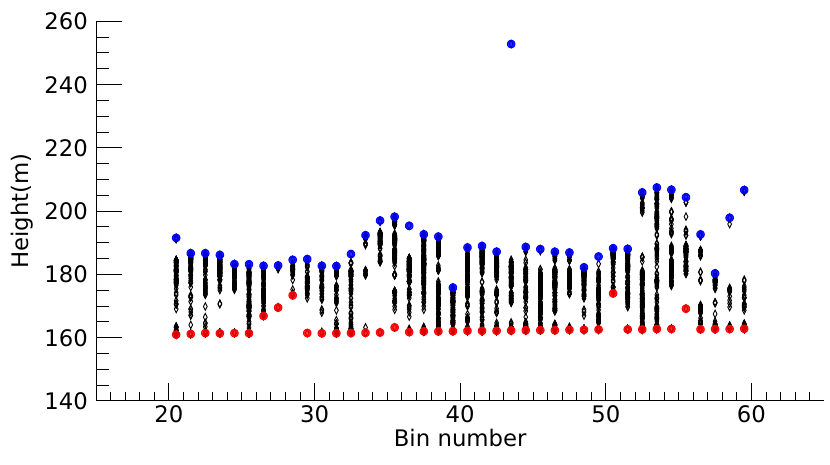
Figure 6. A small section of contiguous bins. Height values are shown in black centered on the correspondent bin. The top value, displayed in blue, is used when constructing the surface image. The bottom value, displayed in red, is used when constructing the terrain image. An outlier influence is visible on bin